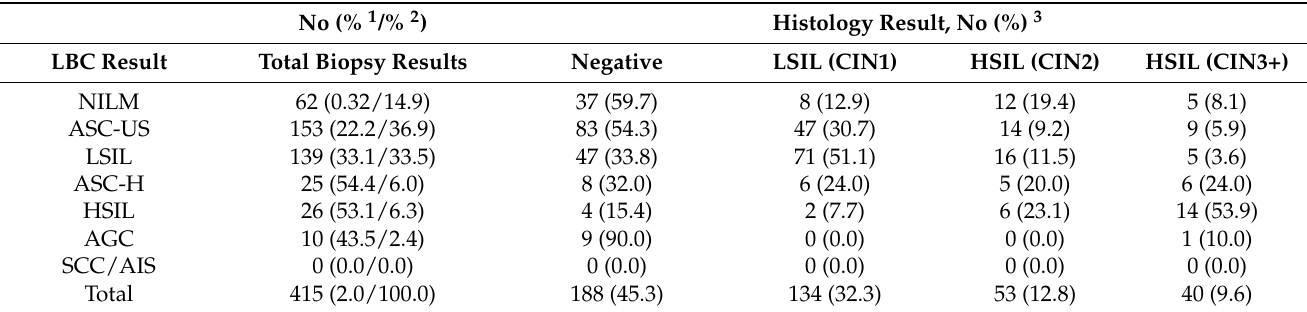
Table 7. The histologic correlation for LBC (CHC).